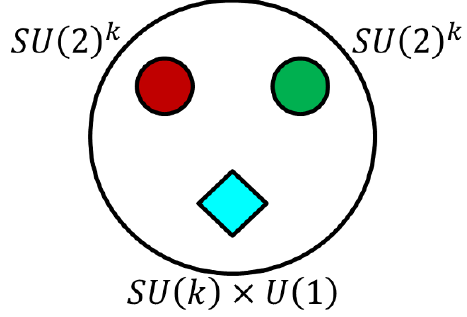
Figure 2 . The formal depiction of the trinion we suggest. The trinion has two maximal punctures with SU(2) k symmetry and a novel maximal puncture with SU( k ) (cid:2) U(1) symmetry. The novel puncture is maximal in the sense that the symmetry associated to it can be gauged to glue together di(cid:11)erent